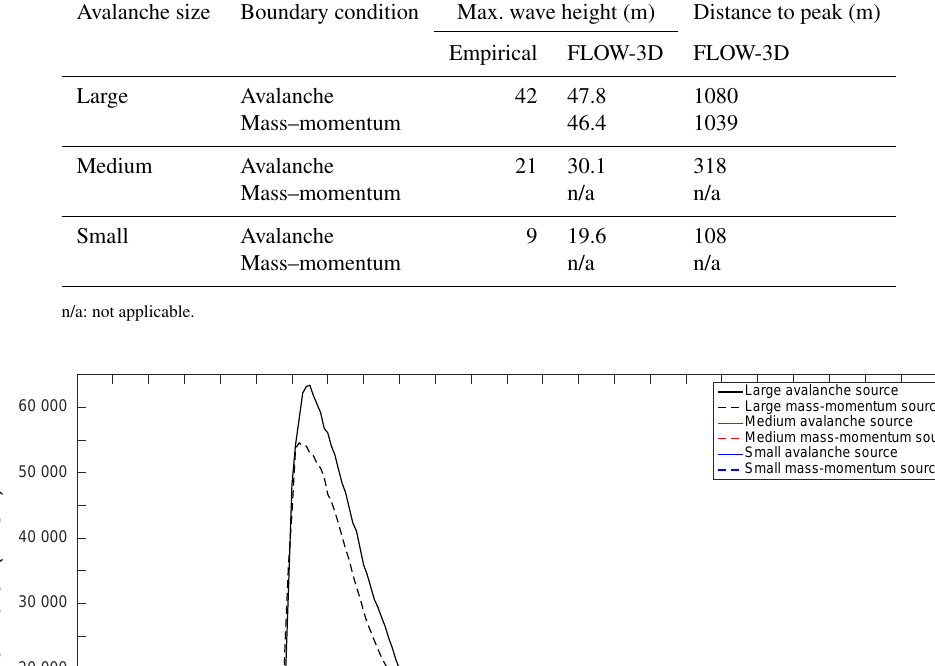
Table 3. Comparison of maximum wave heights for FLOW-3D and empirical calculations. Avalanche size